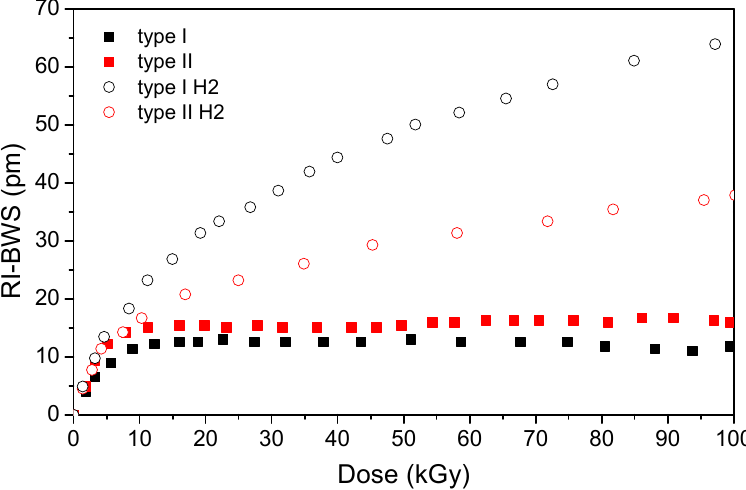
Figure 6. BWS induced by γ -rays at RT with a dose rate of 0.94 Gy/s, up to 100 kGy TID (irradiation temperature between 25 ◦ C and 65 ◦ C), on two type I and two type II gratings written with an fs-laser (at 800 nm, a pulse width of 120 fs, and repetition rate of 100 Hz) into the acrylate coated Ge-doped fiber Corning SMF28e. For each grating type, one FBG was inscribed into an H 2 -loaded fiber and the other in an unloaded one. All the gratings were thermally treated for 4 days at 100 ◦ C. To write type I FBG, the laser power was reduced by increasing the distance between the PM and the fiber. Data extracted from [82].